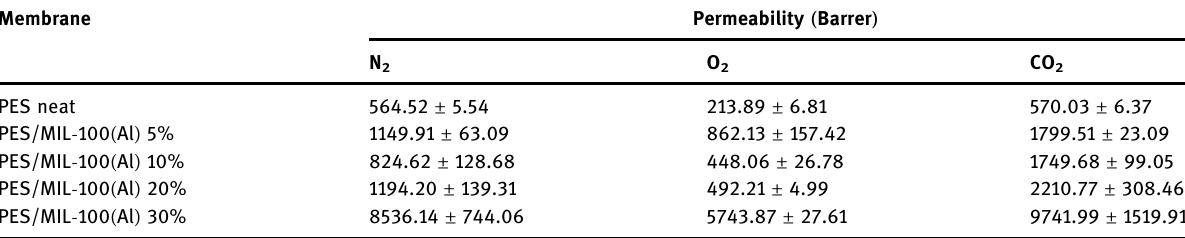
Table 4: Gas Permeability of the PES/MIL - 100 ( Al )